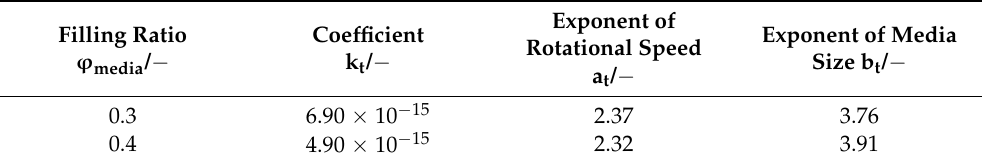
Table 9. Variables for model equation (Equation (16)) to describe the collision frequency based on rotational speed n (in min − 1 ) and media size d (cid:2923)(cid:2915)(cid:2914)(cid:2919)(cid:2911) in mm).